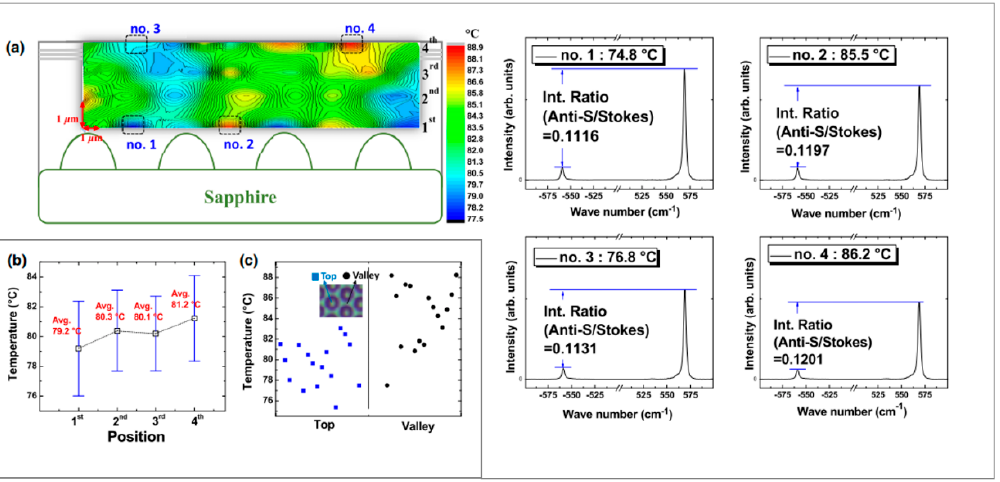
Figure 9. ( a ) Temperature distribution in the x-z cross-section obtained from Stokes and anti-Stokes intensity ratio evaluations. Extreme Raman spectra points are shown from no: 1-4. LED T j is assumed to be the same as the top surface temperature. ( b ) Average temperatures at different locations. ( c ) Scatter temperature plot of 32 different positions at top and valley sites. Reprinted/adapted with permission from Ref. [163]. Copyright 2018, American Physical Society.